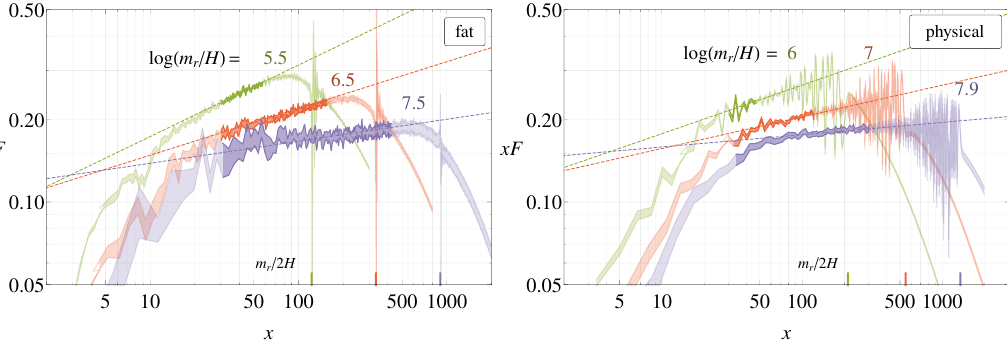
Figure 14: The instantaneously emitted axion energy density spectrum F [ x , y ] as / H ) for fat strings a function of x = k / H at different times (represented by y = m r (left) and physical strings (right). We also plot dotted lines corresponding to the best fit values of q for each time (obtained by fitting the q as a linear function of log over the complete data set, leading to eq. (17)). An increase in the slope q with log can be seen for both the fat and physical string systems. The highlighted region corresponds / 4 ] , which we use for the fit of q in Section 2. to the data points in the range [ 30 H , m r / ( 2 H ) at each time, above which emission is highly suppressed. We also indicate m r